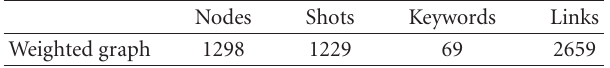
Table 2: Numerical statistics for the weighted graph. Nodes Shots Keywords